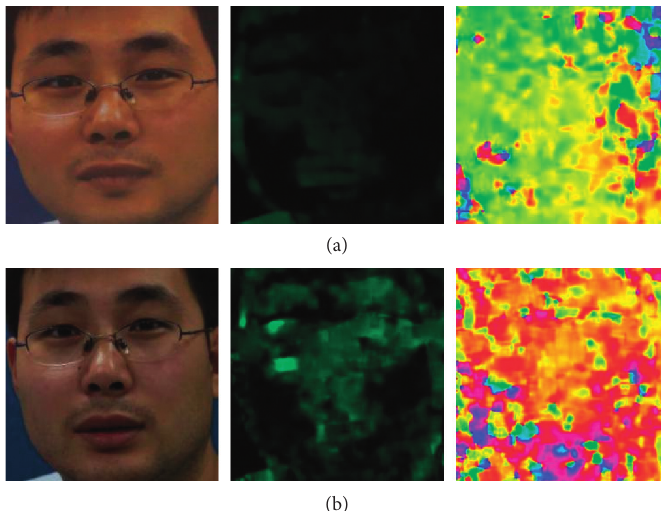
Figure 9: CASIA-MFSD examples after preprocessing. From left to right: texture image, optical flow magnitude, and optical flow direction. Among them, (a) fake face and (b) real face.